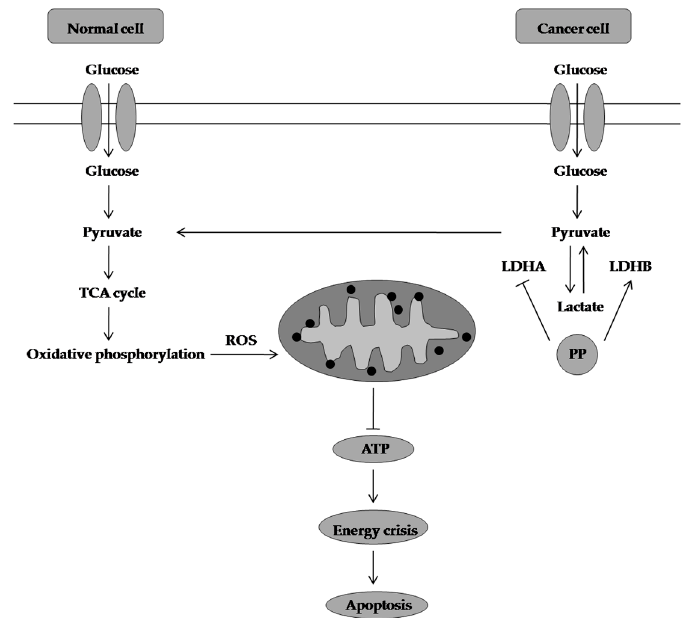
Figure 8. Action of PP in breast cancer. PP downregulates LDHA expression and upregulates LDHB expression. The ROS generated during oxidative phosphorylation decreases the ∆ψ m and this leads to energy crisis and cell death. TCA cycle: tricarboxylic acid cycle, ROS: reactive oxygen species, ATP: adenosine triphosphate, PP:panepoxydone, LDHA: lactate dehydrogenase A, LDHB: lactate dehydrogenase B, ∆ψ m: mitochondrial membrane potential.